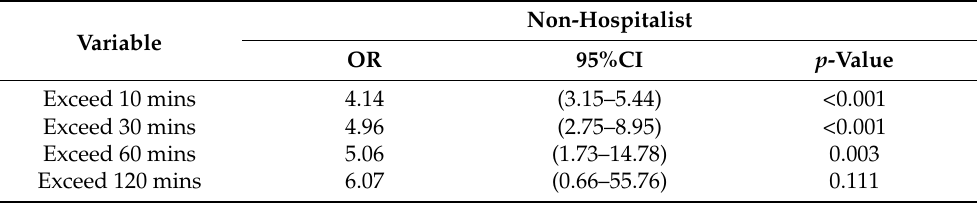
Table 5. Results of logistic regression analysis on the time to response a medical call of non-hospitalist compared to hospitalists + .